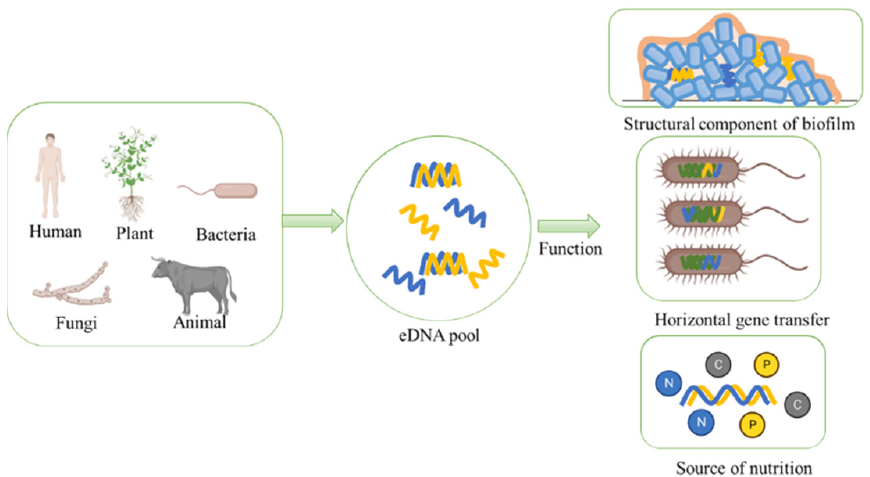
Figure 2. The origin and ecological functions of eDNA. eDNA could be obtained from different species such as human, plant, bacteria, fungi, and animal. The eDNA has three main ecological functions, firstly, it is a structural component of biofilm; secondly, it can take part in HGT; thirdly, it is a main compound in nutrient cycle.